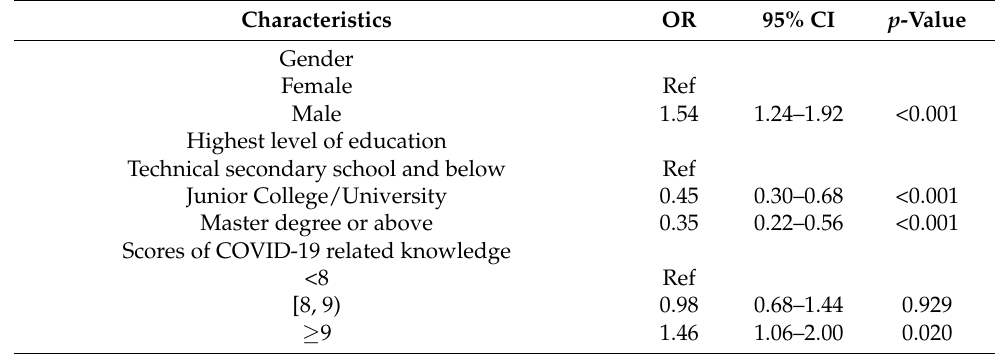
Table 7. Multivariate logistic regression analysis of influencing factors of the respondents’ willingness to vaccinate against